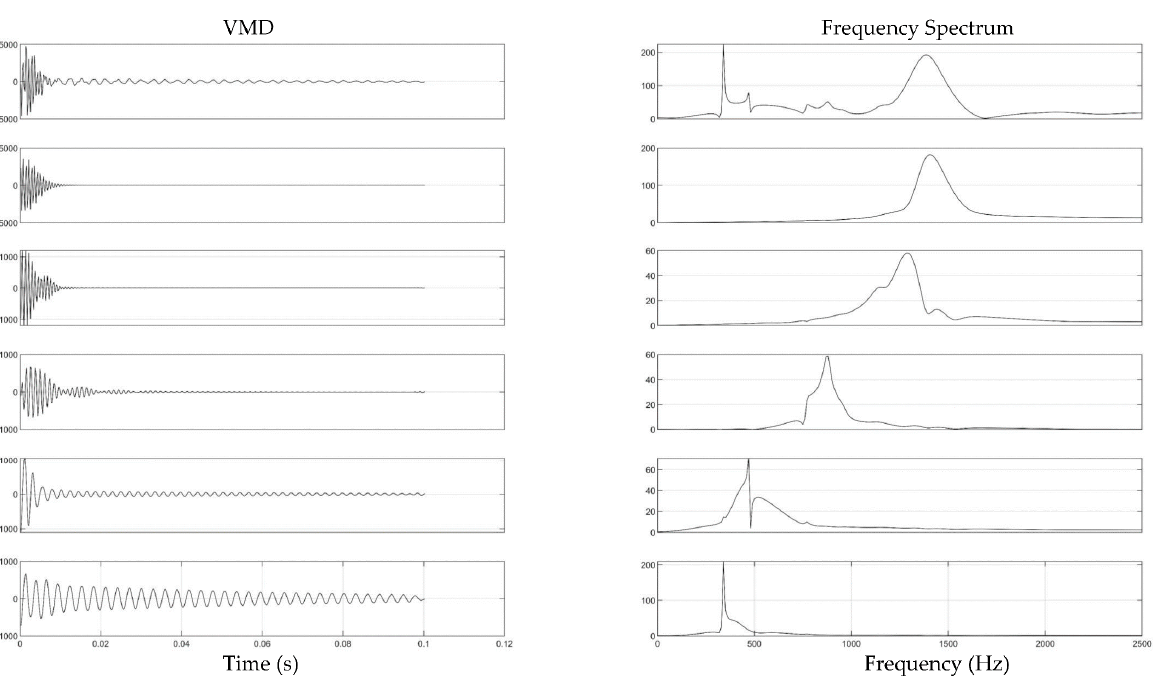
Figure 16. Acceleration response VMD decomposition (no loosening).